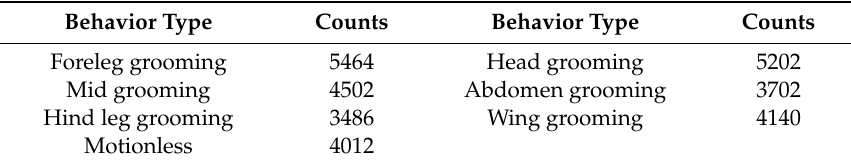
Table 1. The number of feature images for each grooming behavior.